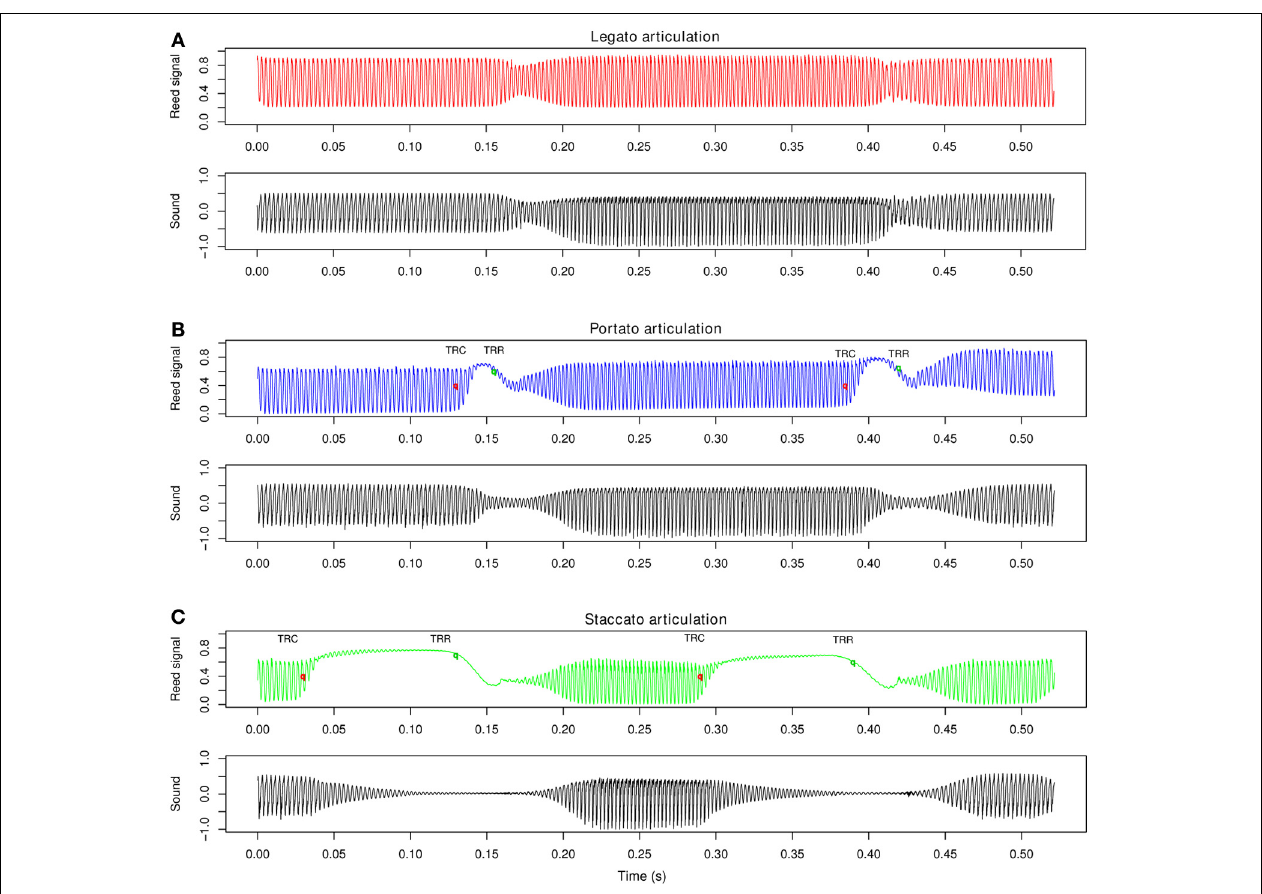
FIGURE 3 | Alto-saxophone sensor reed signals and radiated sound recorded in an anechoic chamber, showing a note transition (d2–e2–d2) under a tempo instruction of 250ms inter-onset interval (audio sampling rate 44.1kHz). Examples are taken from the pool of stimuli for the perception experiment in section 3. (A) Reed signal for legato articulation